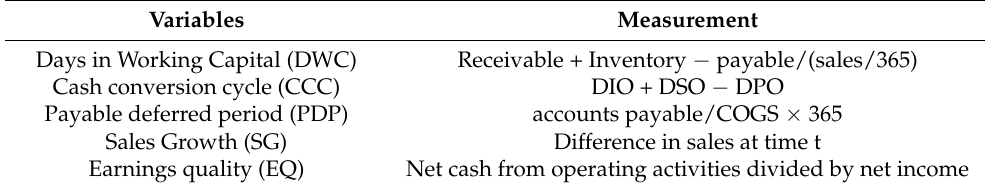
Table 1. Working capital management